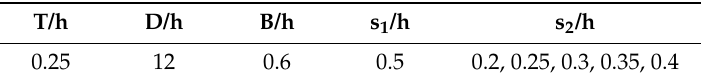
Table 1. Parameters considered in Section